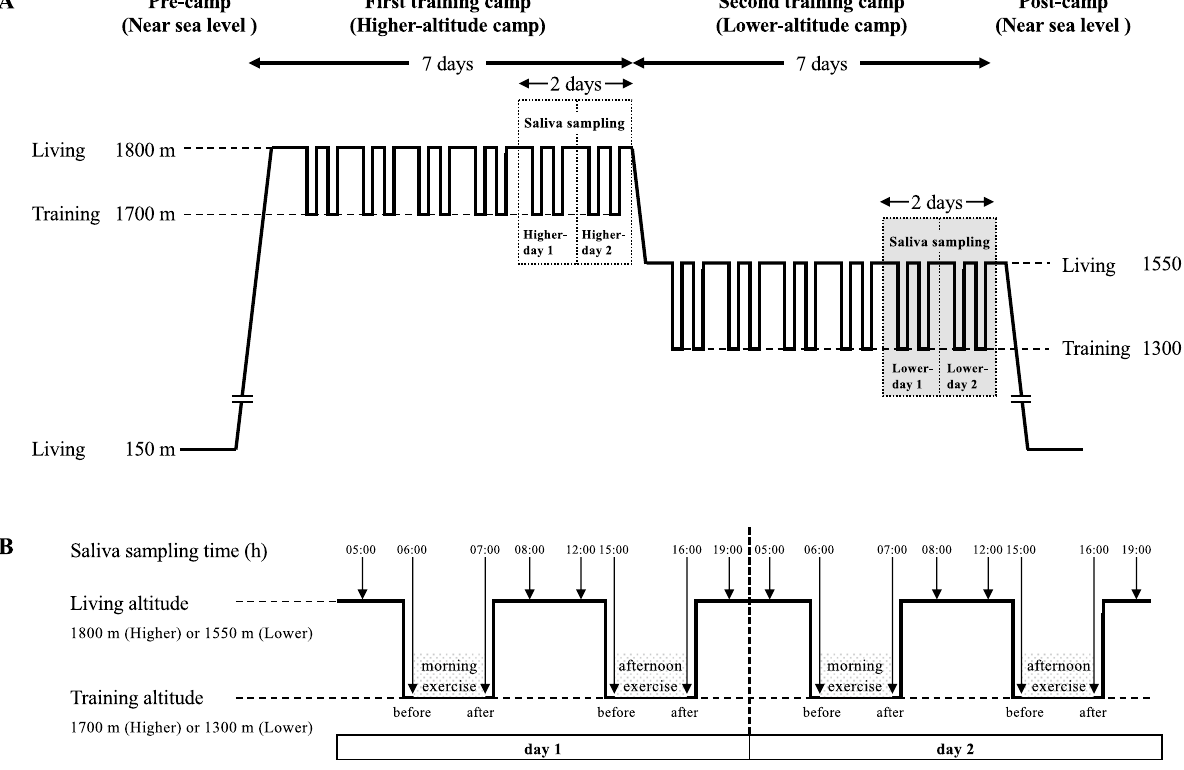
Figure 1. The study design of the first and second training camps of 12 female long-distance runners. The altitudes at which the runners lived and trained during the two training camps and pre- and post-camp ( A ). The schema of altitudes and saliva sampling time in runners on the last 2 days during each training camps ( B ). The downwards arrows denote the saliva sampling from the runners, and the tips of the arrows denote the altitudes at the time of sampling at both camps. Higher-day 1, day 1 at the higher-altitude camp; Higher-day 2, day 2 at the higher-altitude camp; Lower-day 1, day 1 at the lower-altitude camp; Lower-day 2, day 2 at the lower-altitude